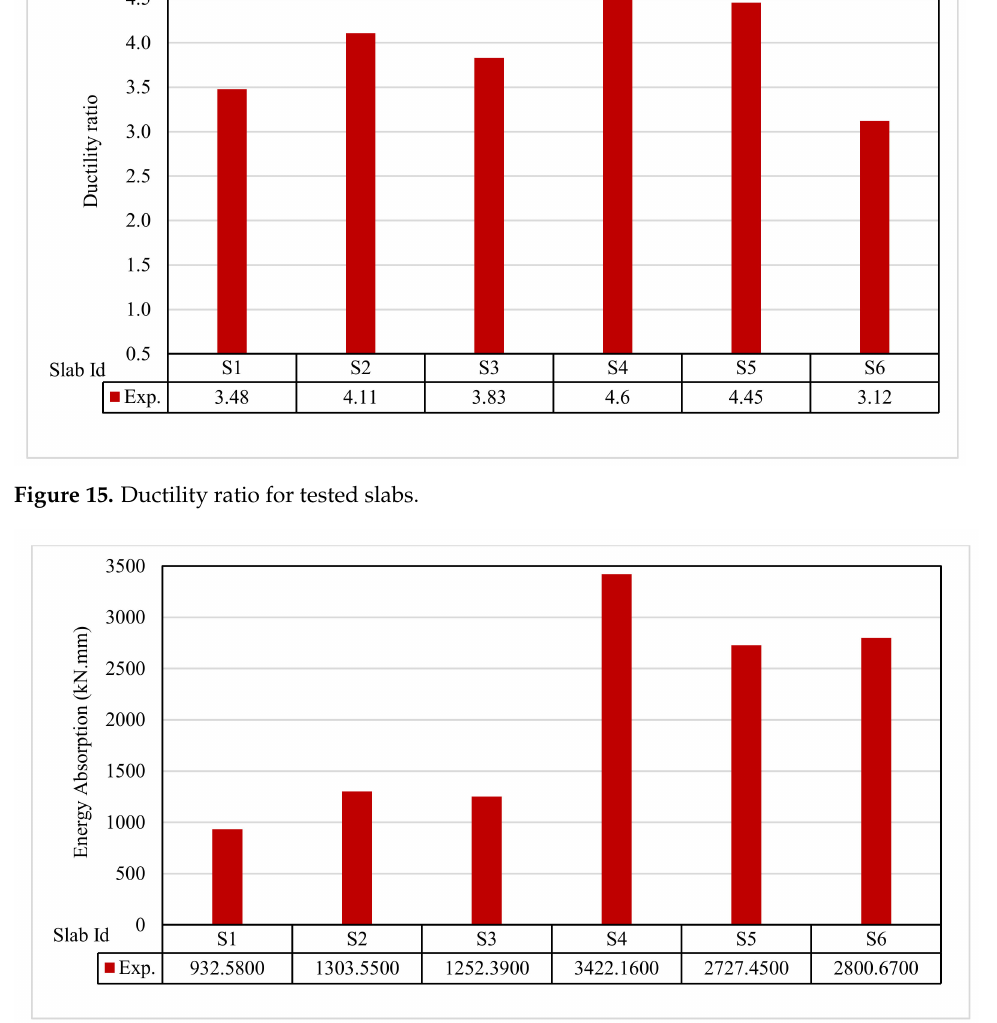
Figure 16. Energy absorption for tested